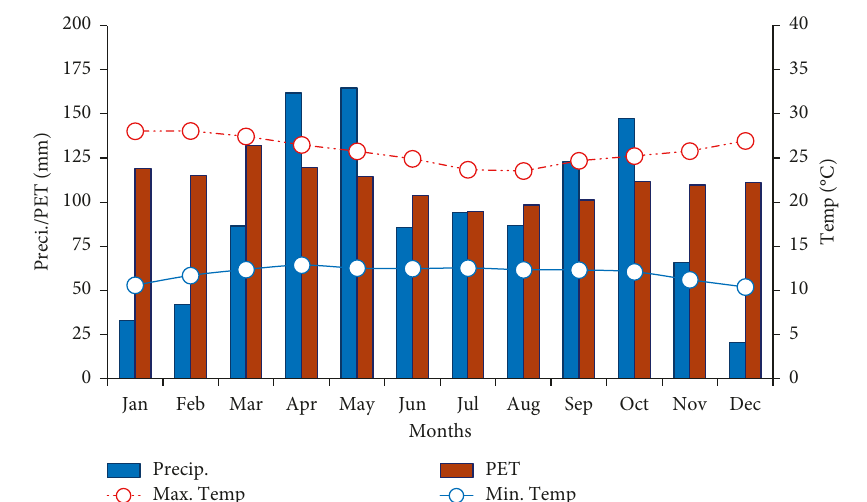
Figure 1: Location map of the study district.